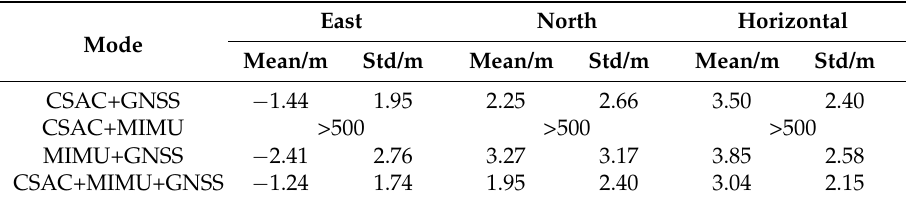
Table 5. Navigation result comparison of the open-sky route.